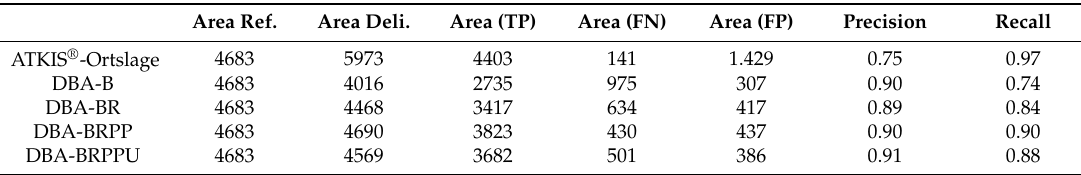
Table 6. Area of reference, delineation, true positive (RP), false positives (FP) and false negative (FN) classified area in